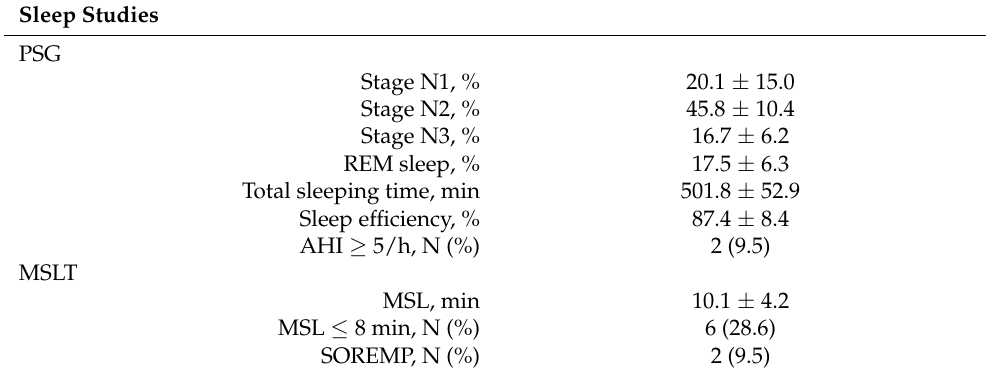
Table 2. Sleep structures after the combination